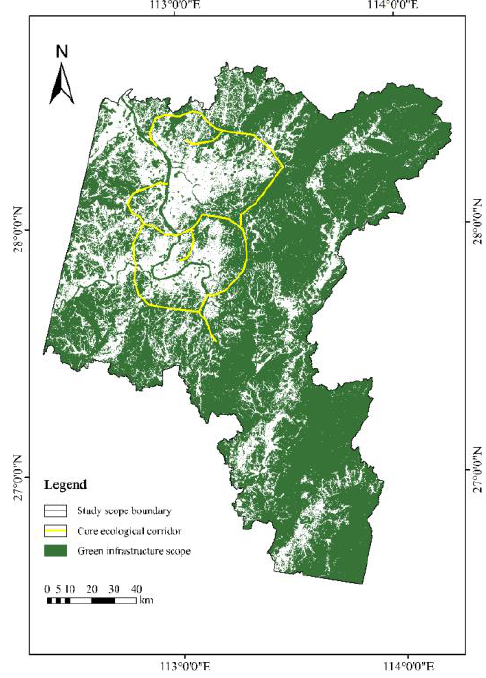
Figure 3. Green infrastructure and corridors in 2018.